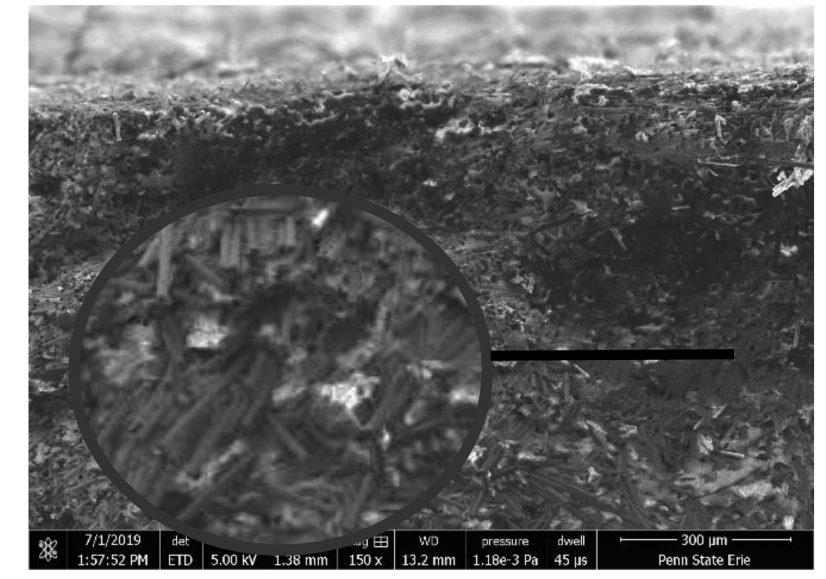
Figure 5. SEM image of the specimen with 50% CF3, showing fiber alignment near the surface of the